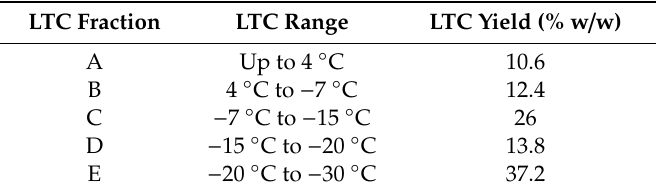
Table 5. Separation of PUFAs by